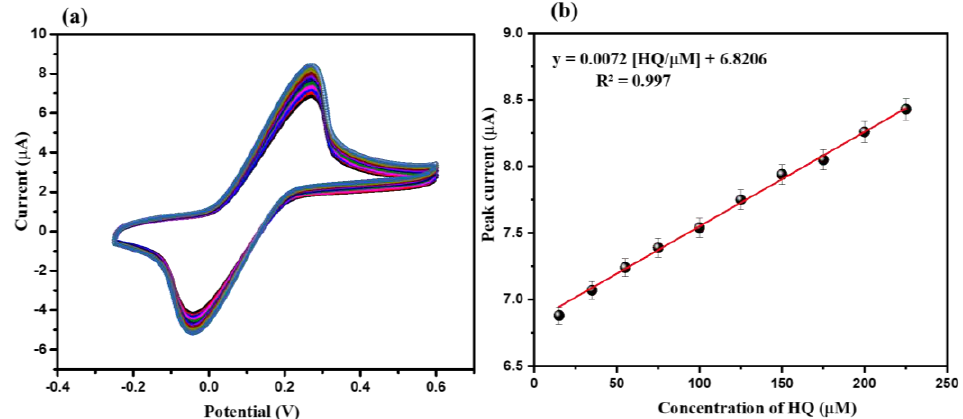
Figure 5. CVs ( a ) of CeO 2 /GCE in presence of HQ (15 µ M, 35 µ M, 55 µ M, 75 µ M, 100 µ M, 125 µ M, 150 µ M, 175 µ M, 200 µ M, and 225 µ M) in 0.1 M PBS (pH = 7.0; applied scan rate = 50 mV/s). Calibration plot ( b ) of peak current versus concentration.